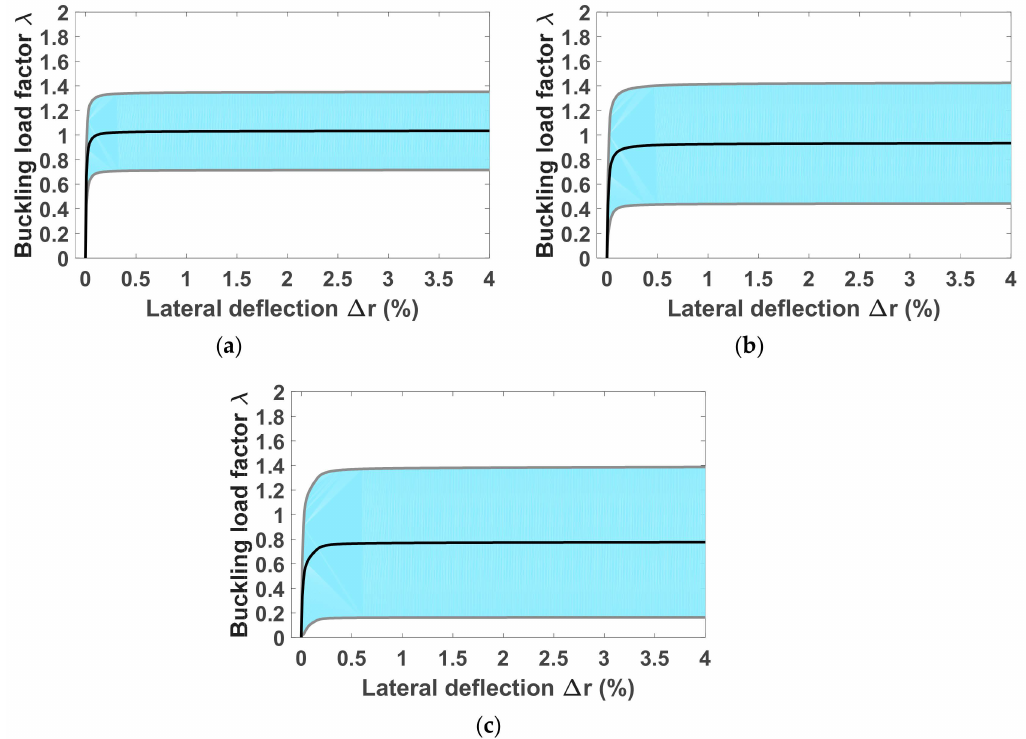
Figure 9. The 95% confidence intervals of column buckling behavior from 0 to 4% of lateral deflection for ( a ) δ G = 0.3, ( b ) δ G = 0.5 and ( c ) δ G =